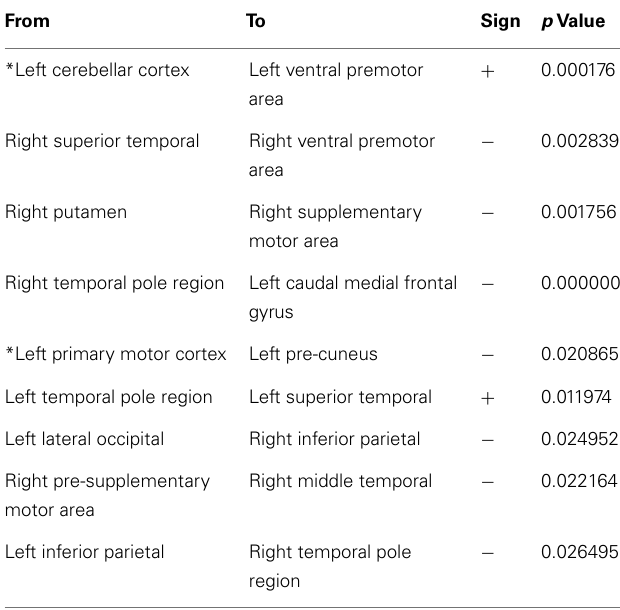
Table 2 |The individual directional connections within this selected network found to significantly correlate with clinical rigidity scores.